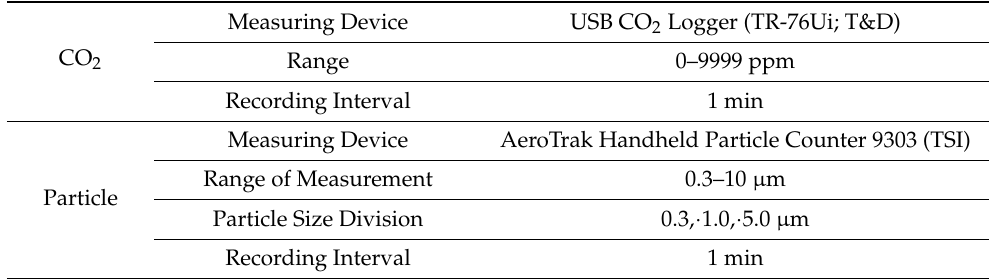
Table 2. Overview of